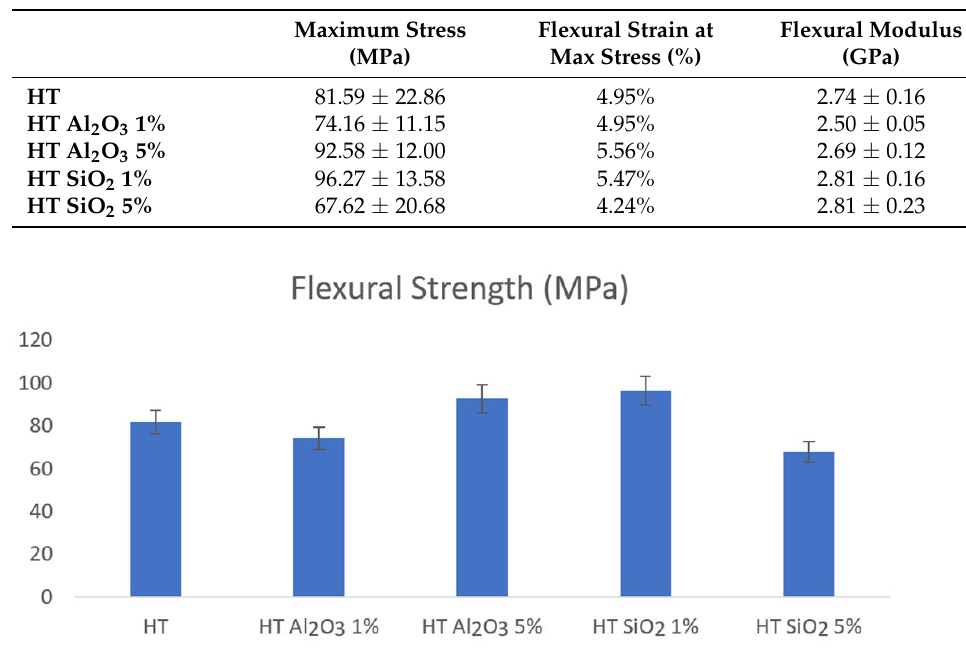
Figure 10. Flexure tests of the fabricated specimens for mechanical properties assessment. The dotted line corresponds to the Flexure Modulus Mean Value (MPa), while the orange bars denote the percentage difference from the Formlabs Standard High Temp resin.